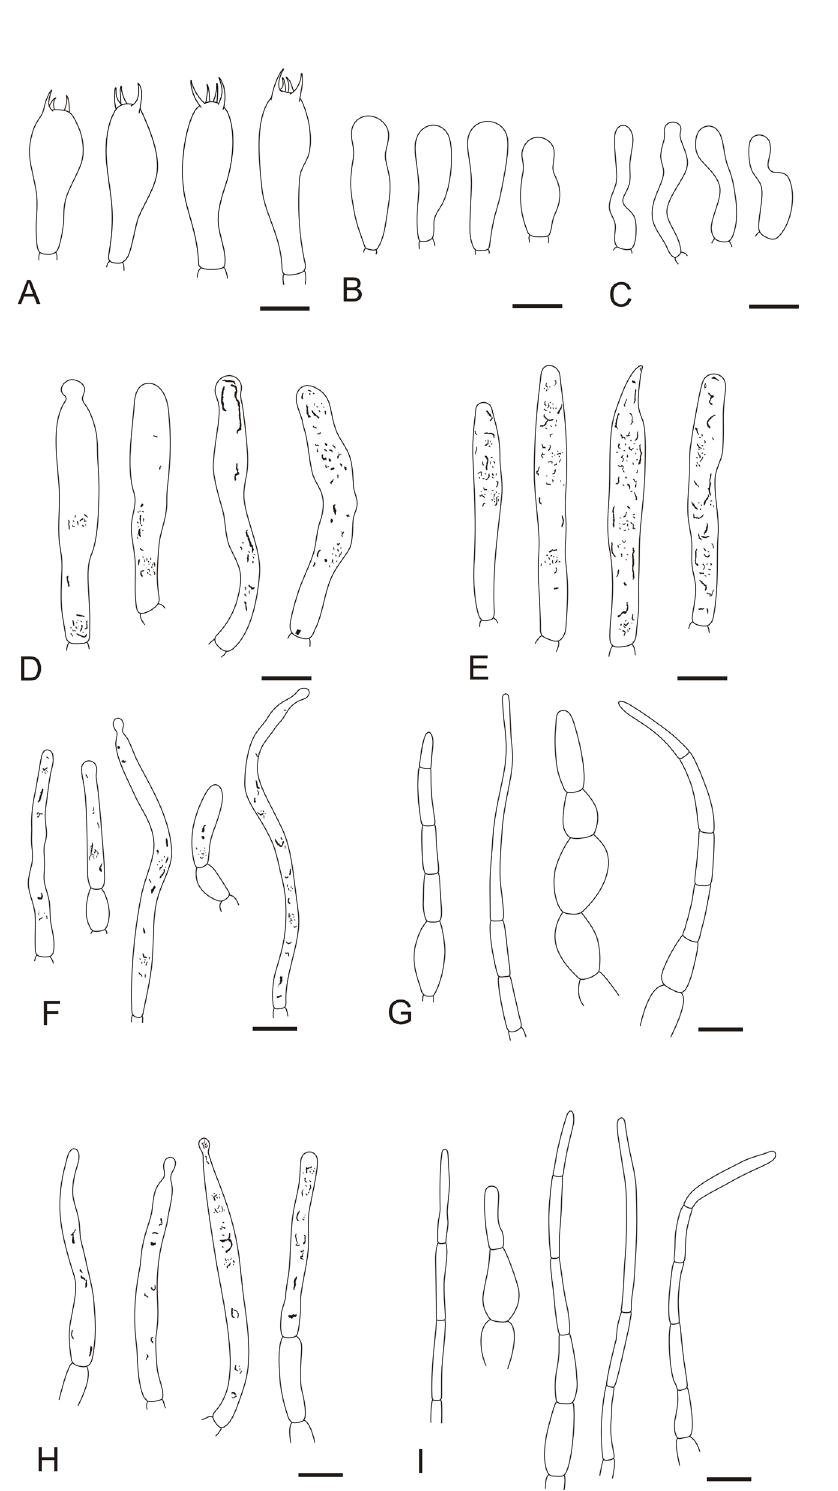
Fig. 4. Microscopic structures of lamellae of Russula pseudopunicea C.L.Hou, G.Q.Cheng & H.Zhou sp. nov. , holotype (BJTC ZH1392). A . Basidia. B . Basidiola. C . Marginal cells. D . Pleurocystidia. E . Cheilocystidia. F . Pileocystidia near pileus margin. G . Hyphal terminations near pileus margin. H . Pileocystidia near pileus centre. I . Hyphal terminations near pileus centre. Scale bars = 10